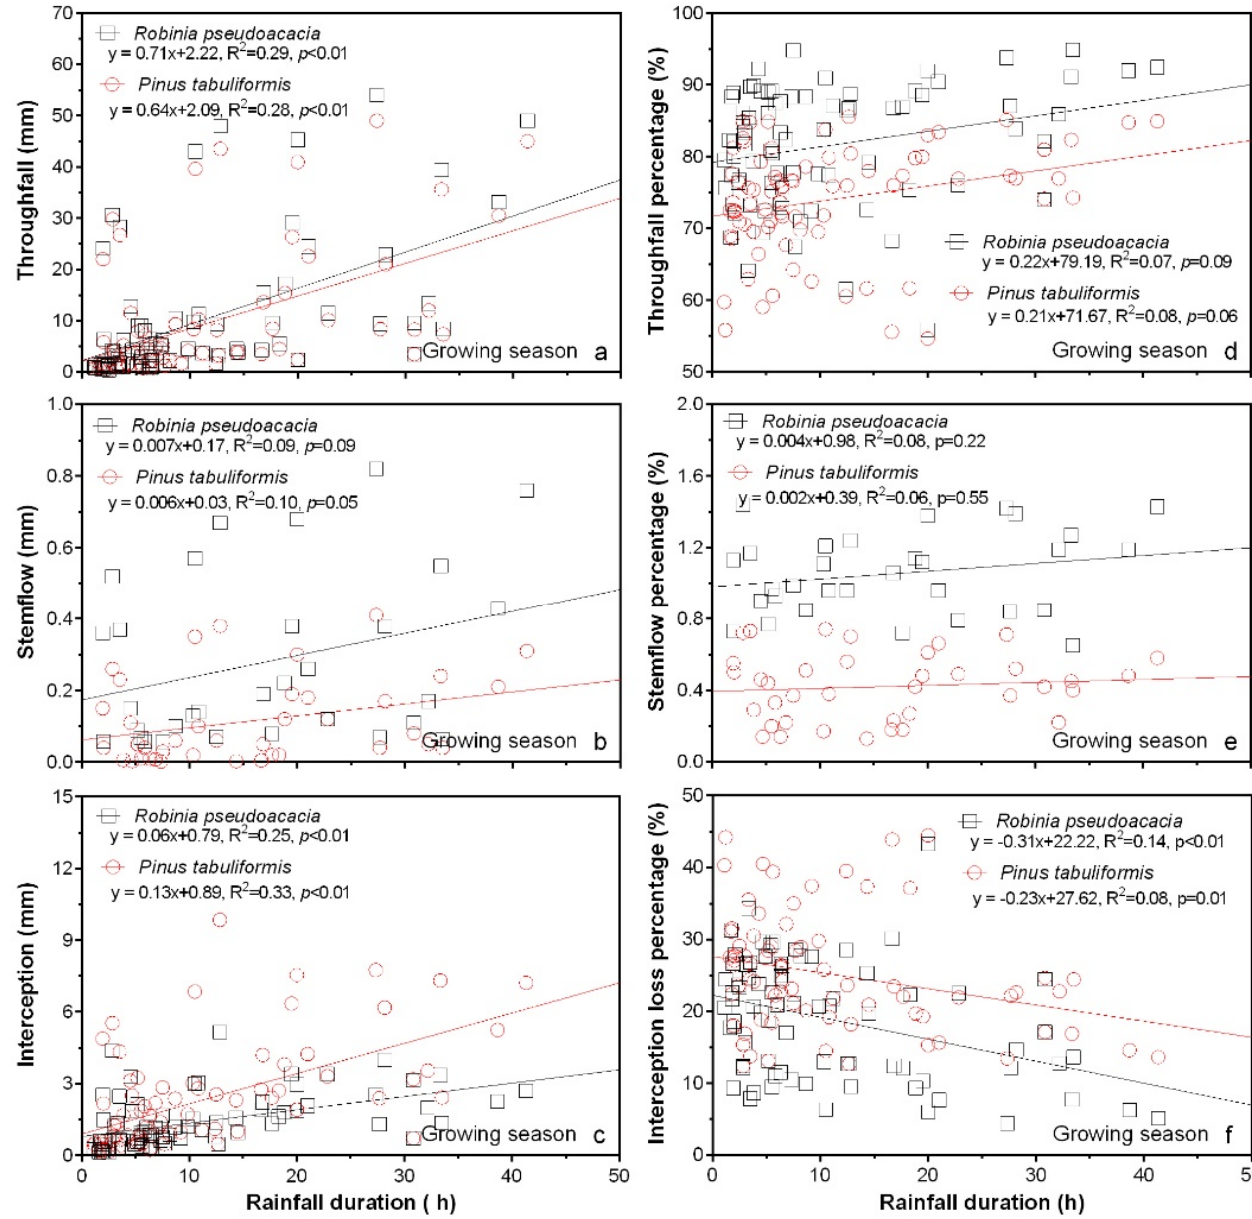
Figure 4. Relationships between individual rainfall duration and rainfall partitioning components for R. pseudoacacia ( a – c ) and P. tabuliformis ( d – f ) during the growing season in 2015 and 2016.